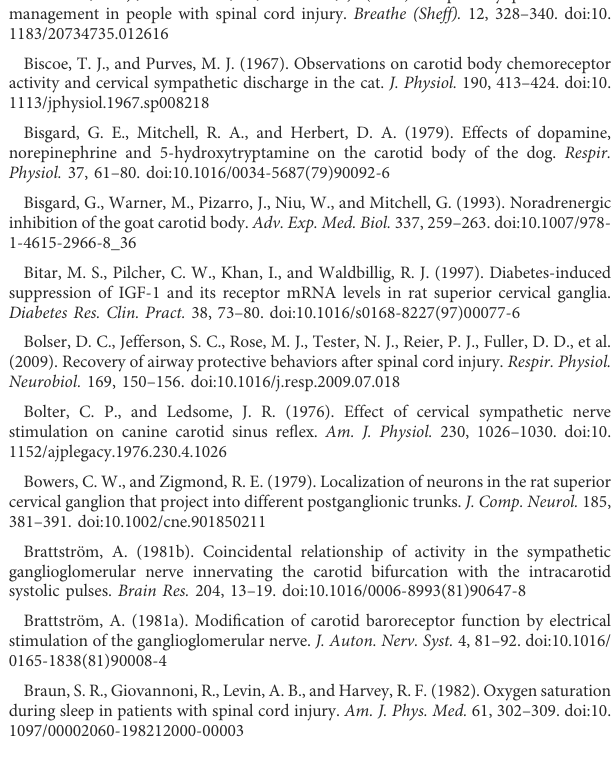
SUPPLEMENTARY FIGURE S24 (A) Arithmetic changes in Non-Eupneic Breathing Index/Frequency of breathing index (NEBI/Freq) from Pre-values in sham-operated (SHAM) rats and in rats with bilateral ganglioglomerular nerve transection (GGNX) during the fi rst 90 s upon return to room-air (RA1-RA5), following the fi ve hypoxic (HX, 10% O 2 , 90% N 2 ) gas challenges. (B) Total arithmetic changes in NEBI/Freq during the fi rst 90 s of the return to room-air phases (RA1-RA5). (C) Total arithmetic changes in NEBI/Freq during the fi rst 5 min of the return to room-air phases (RA1-RA5). The SHAM group had 10 rats. The GGNX group had 12 rats. The data are presented as mean ± SEM. * p < 0.05, signi fi cant response. † p < 0.05, GGNX rats versus SHAM rats. SUPPLEMENTARY TABLE S1 De fi nition of ventilatory parameters described in this study. SUPPLEMENTARY TABLE S2 Information and resting (Pre HX challenge) ventilatory parameters. SUPPLEMENTARY TABLE S3 Qualitative status of resting (Pre-challenge) ventilatory parameters in GGNX and CSNX rats compared to their respective sham-operated (SHAM) controls.